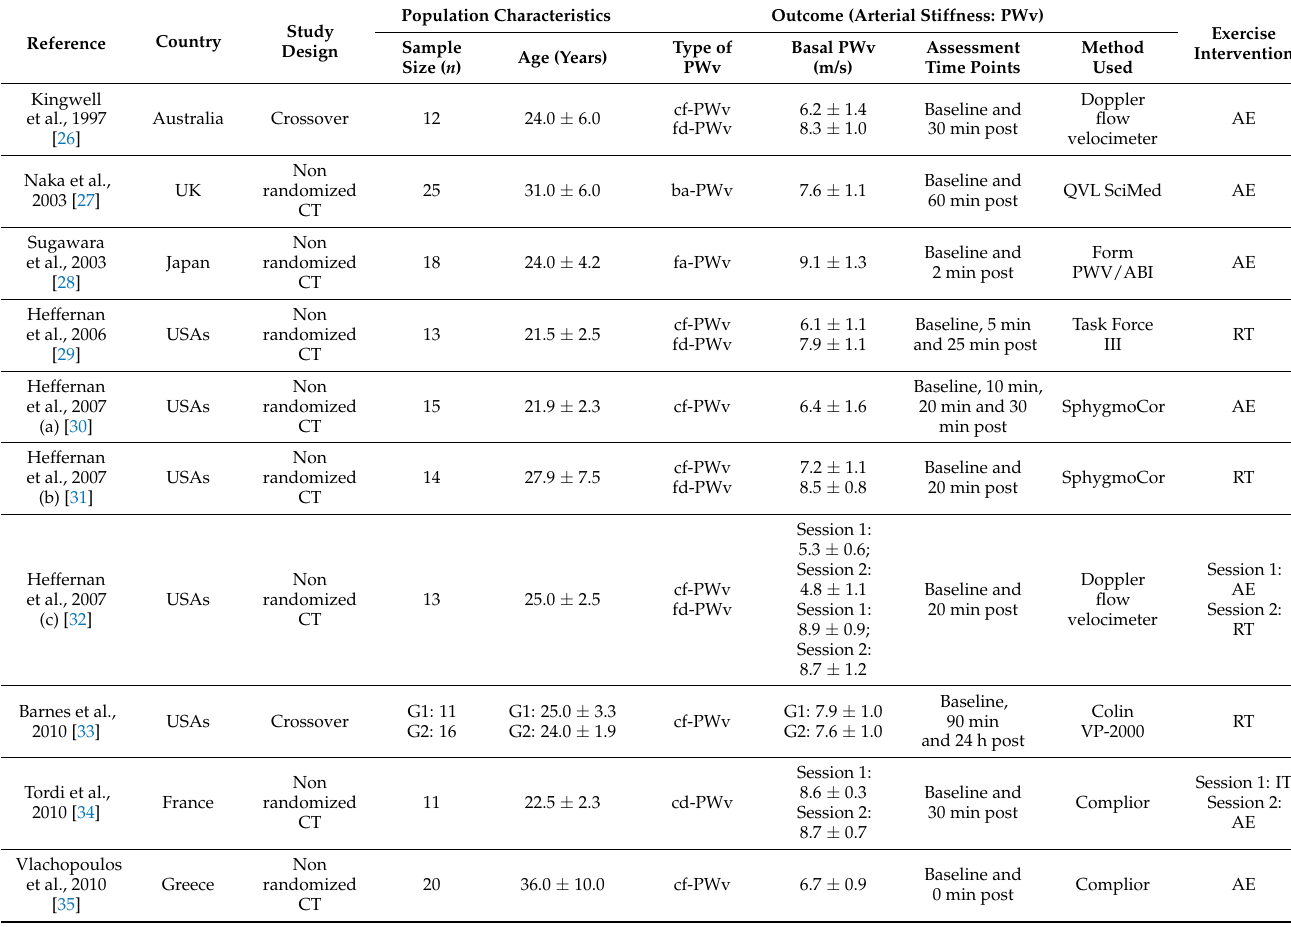
Table 1. Characteristics of studies included in the